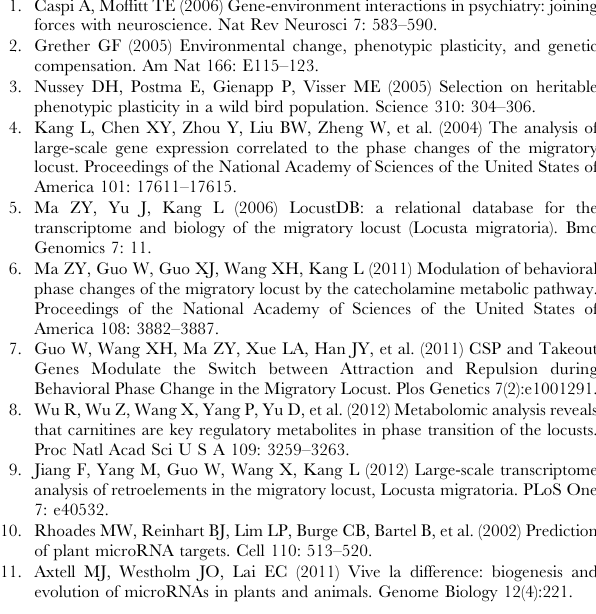
(TIF) Figure S11 Validation of the monoclonal antibody against Ago- 1 protein. Western blot analysis of Ago-1 was performed in tissue lysates (input) and Ago-1 immunoprecipitates (IP). Mouse IgG was used as a negative control. (TIF) Figure S12 Validation of the polyclonal antibodies against the henna and pale proteins. RNAi-induced knockdown of henna (A) and pale (B) was used to validate the antibody specificity. RNAi GFP was used a control. The arrows indicate the single and specific bands of the expected size. (TIF) Table S1 miRNAs searched in Drosophila using the TargetScan database. (XLS) Table S2 miRNAs searched in Locusta migratoria as predicted by the miRanda software. Table S3 Primers used for the qPCR analysis of pale , henna